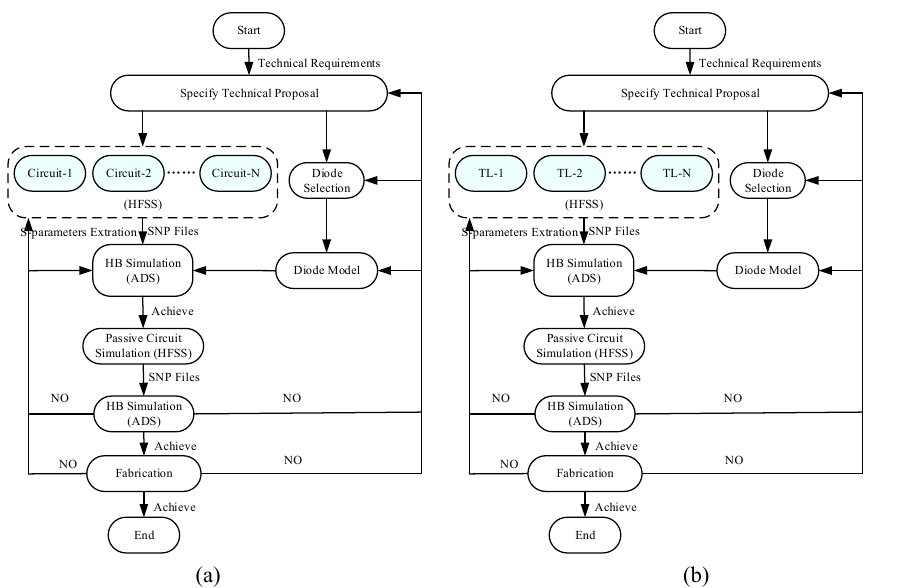
Figure 11. ( a ) SDM method based on circuit units and ( b ) GDM method based on transmission line (TL)